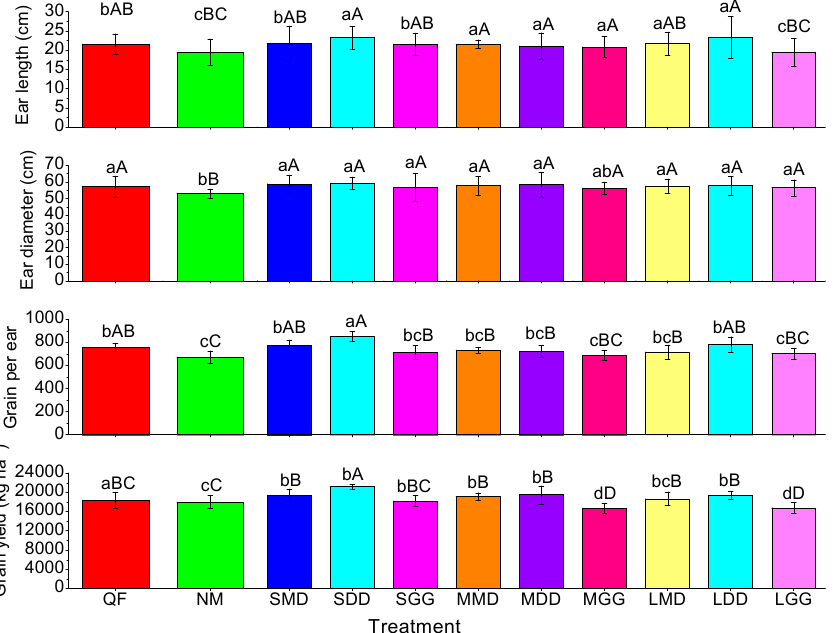
Figure 6. Characteristics of grain yield components during the growing season in 2017 (ear length, ear diameter, grains per ear, and grain yield). Lowercase and uppercase letters indicate significant differences according to LSD 0.05 and LSD 0.01 , respectively ( n = 12). Vertical bars indicate standard errors of means. Bars labeled with different letters (lowercase, uppercase) differed remarkably among the treatments.